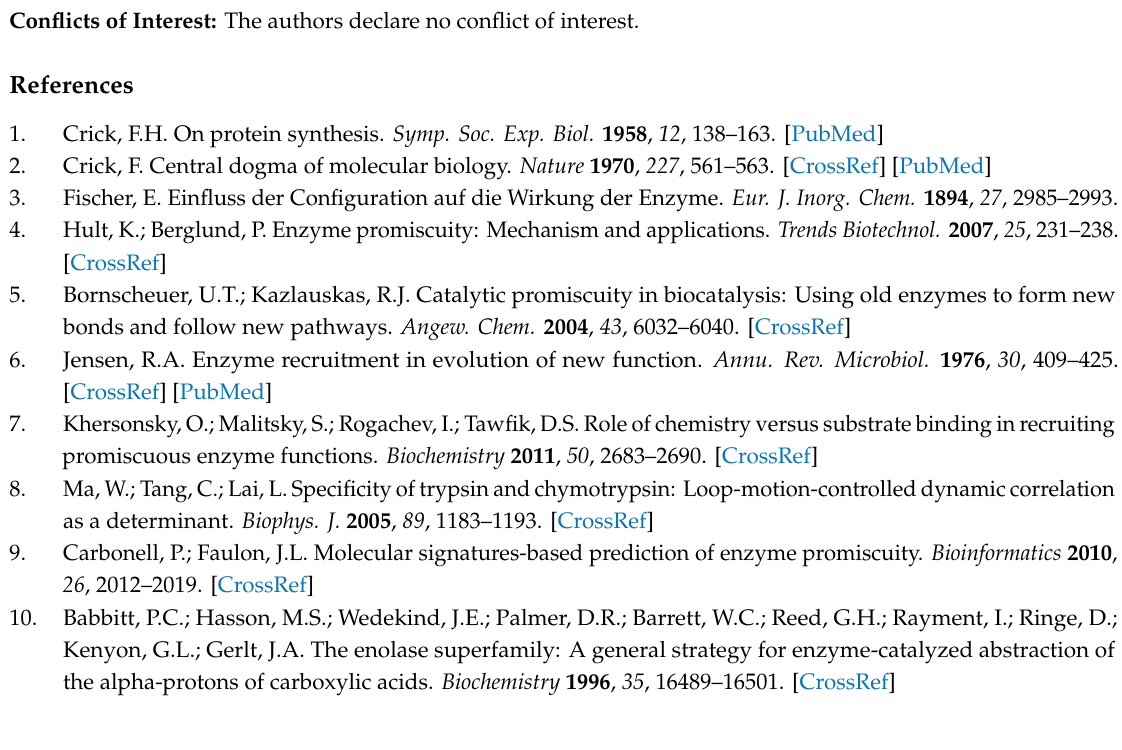
Supplemental Figure S1. Three-dimensional structure of DL-glycerol-3-phosphatase AtGpp2, phosphosugar phosphatase AtSgpp and the constructed mutant AtSgpp3 ∆ built using the modelling package MODELLER. Supplemental Figure S2. AtSgpp mutant construction and purification. Supplemental Figure S3. AtSgpp mutant’s phosphatase activity profile. Supplemental Figure S4. AtSgpp mutant’s phosphatase pH